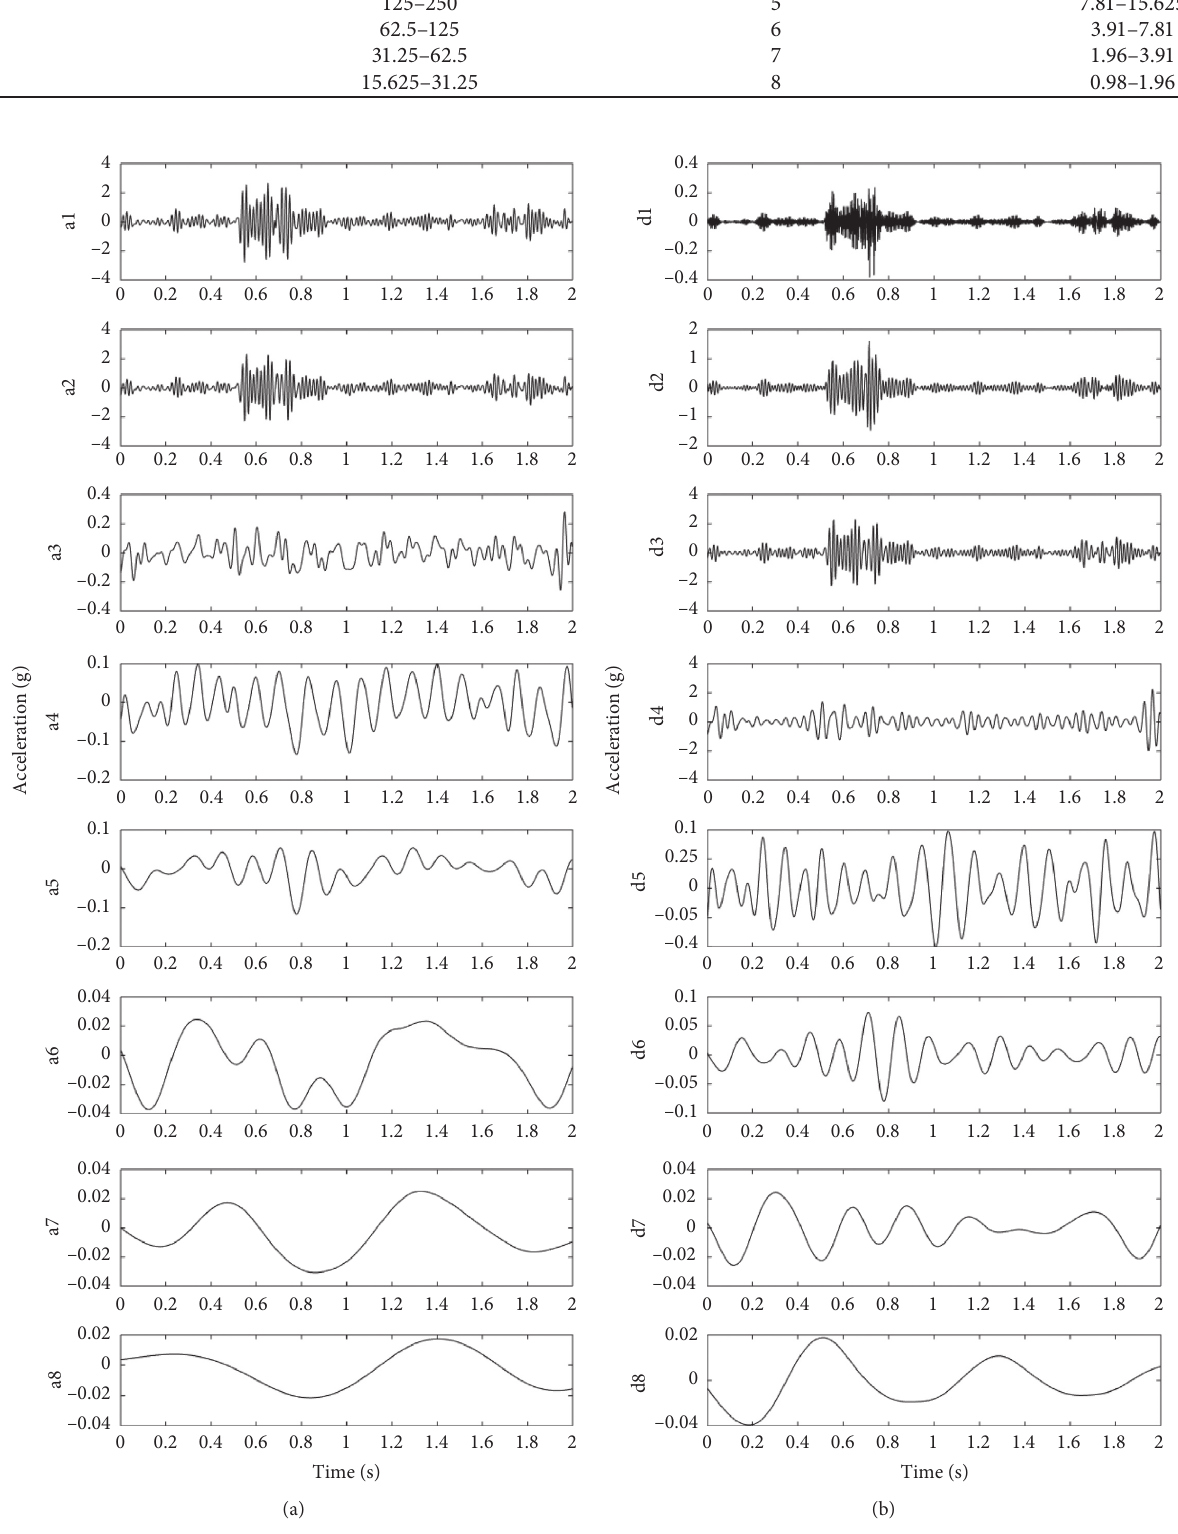
Figure 3: (a) Approximation and (b) detail functions of eight decomposition levels of motor bogie frame acceleration signals with a speed of